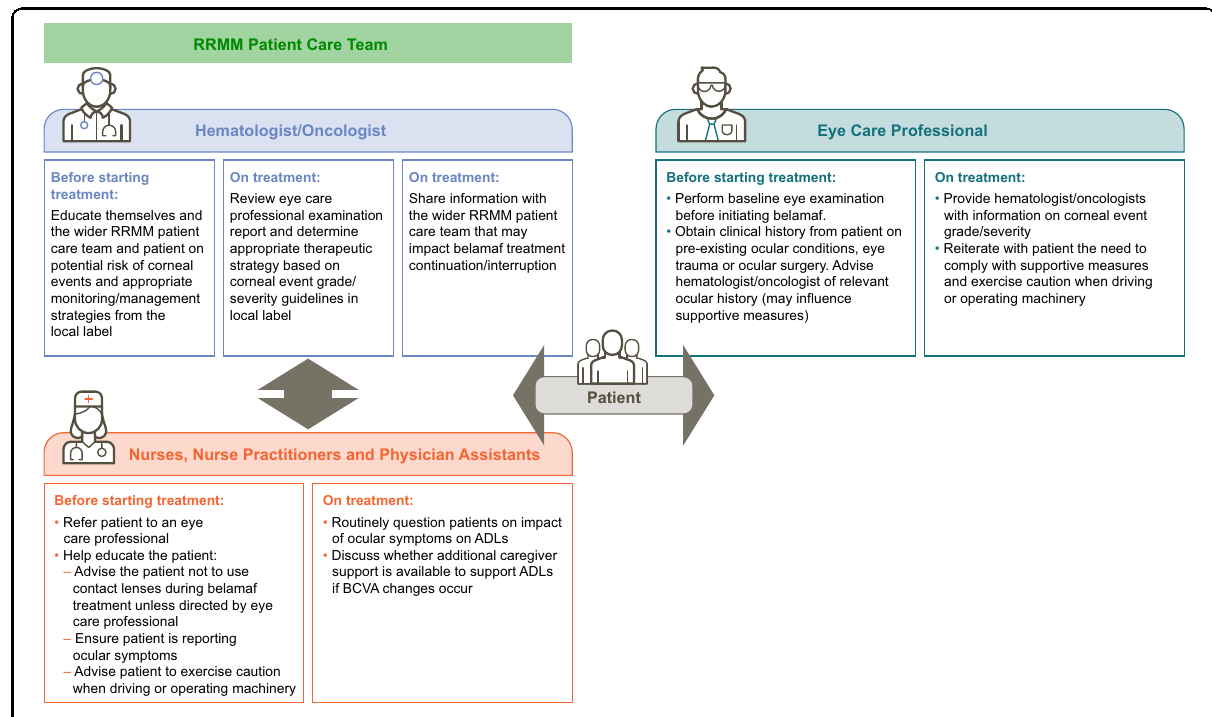
Fig. 2 Flow chart of multidisciplinary approach to mananging corneal events with belamaf: health care professional